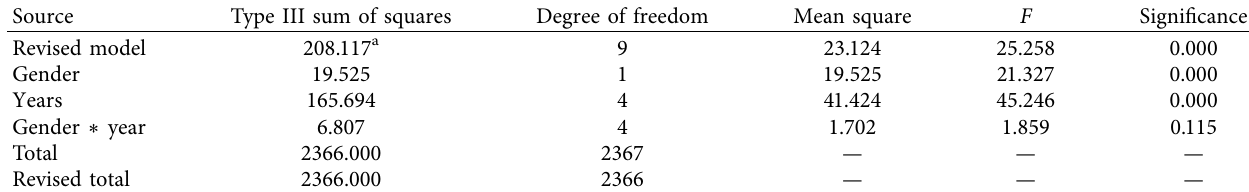
Table 1: Analysis results of the reaction time and year of the World Championship.